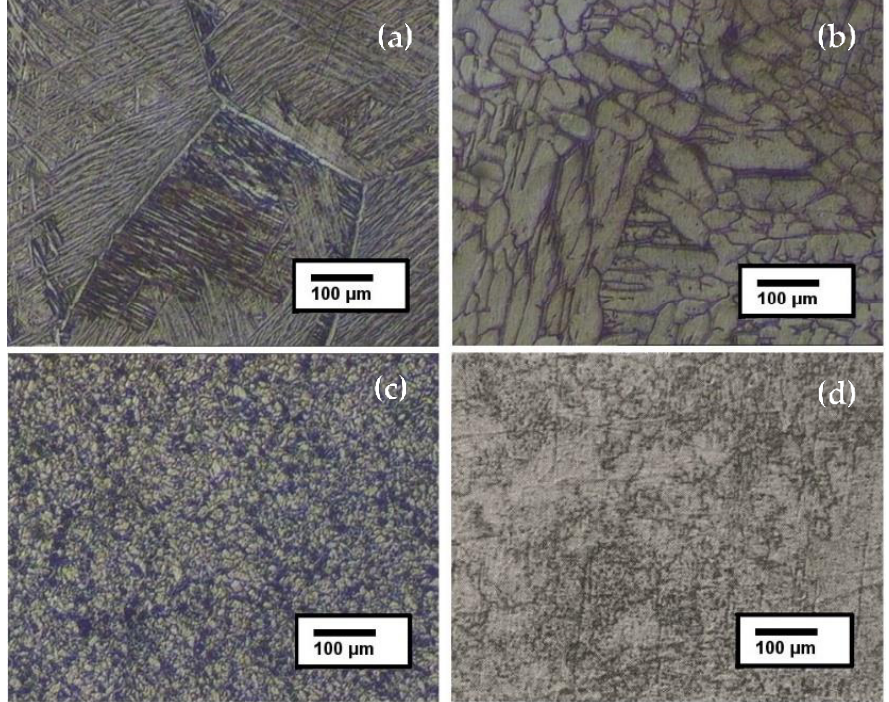
Figure 2. Microstructure of heat-treated Ti-6Al-7Nb alloy: ( a ) quenched in mineral oil, ( b ) quenched in the oven, ( c ) quenched in water, and ( d ) without treatment .